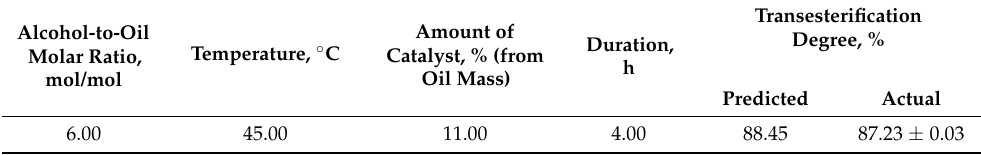
Table 5. Predicted and experimental degree of